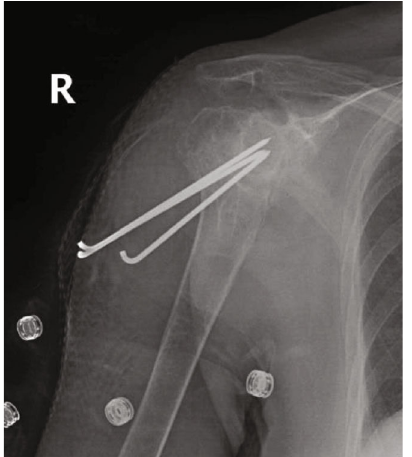
Figure 6: Postoperative plain radiographs of the right shoulder showing percutaneous pinning of the proximal humerus fracture using three